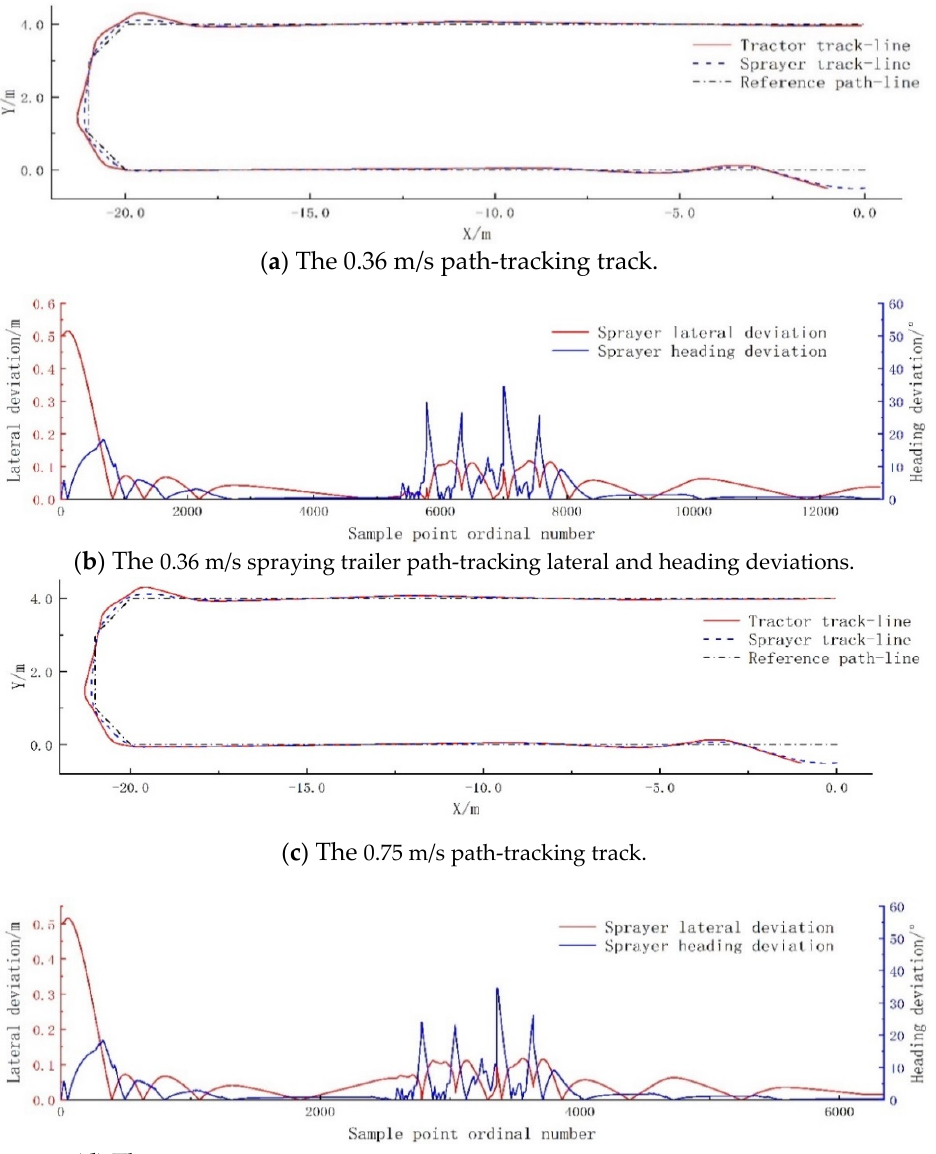
Figure 14. Simulation experimental results.